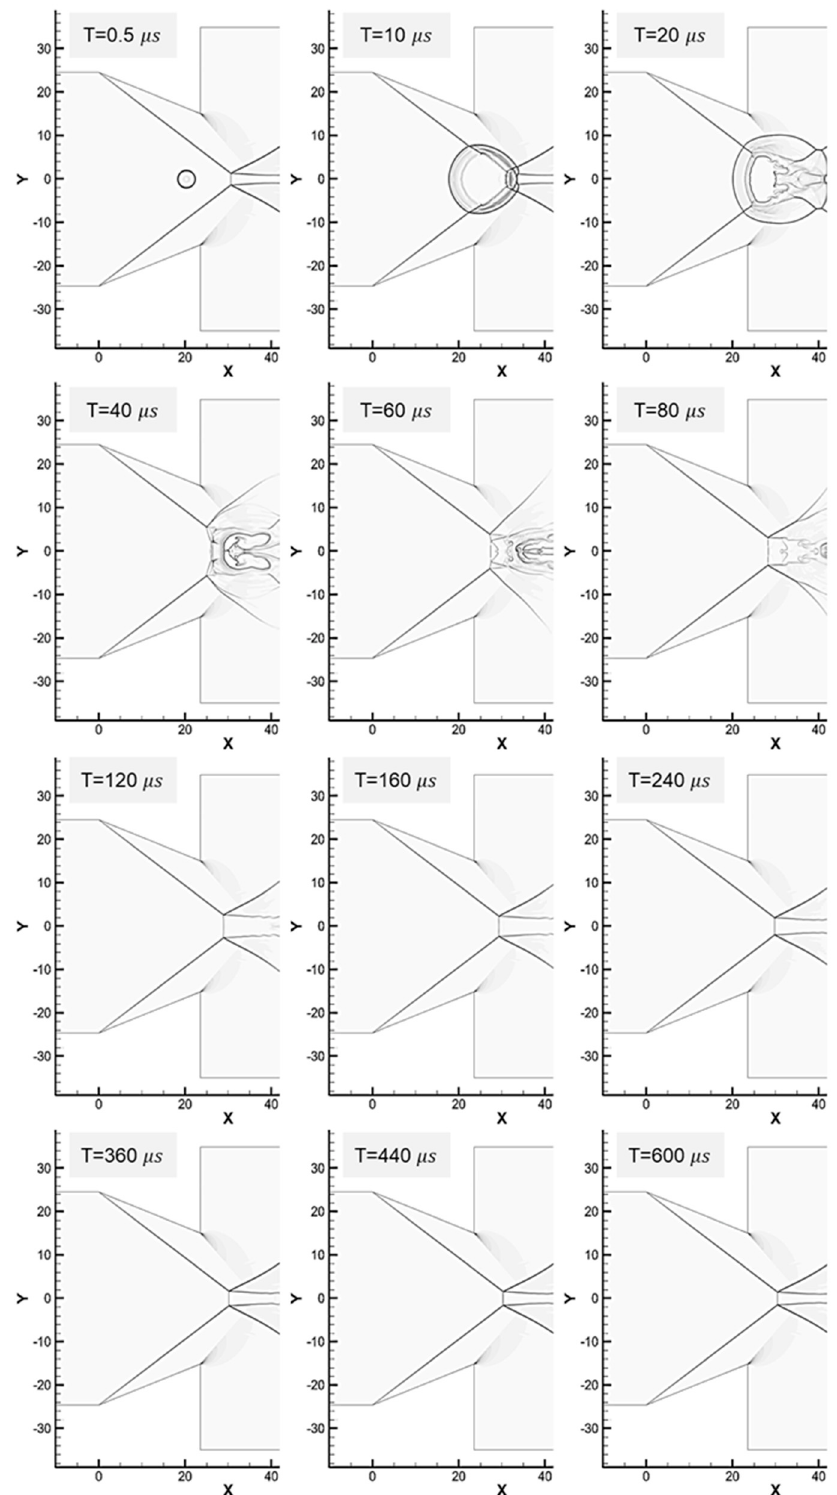
Figure 17. Interaction between blast wave and oblique shock, deposition downstream of the wedges. Energy: 430.0 mJ. Energy: 430.0